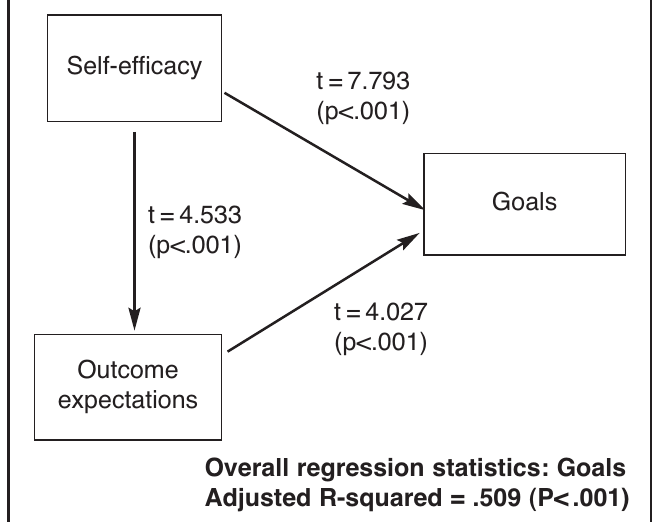
Figure 3. Results for the SCCT